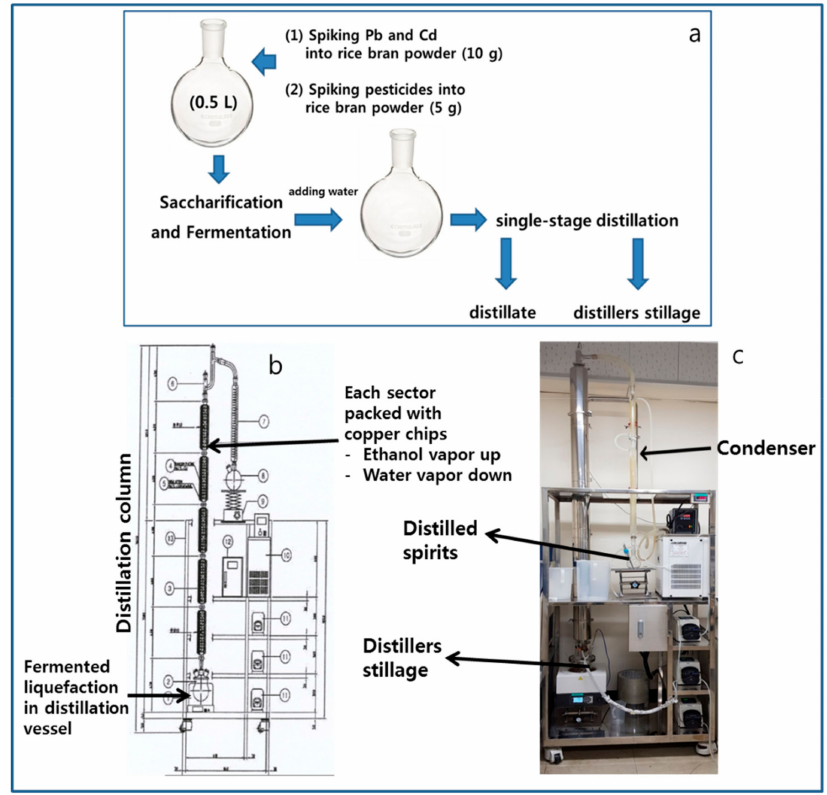
Figure 1. ( a ) Experimental scheme for single-stage distillation; ( b ) illustration of the pilot-plant scale distillation column; ( c ) photograph of the pilot-plant scale distillation column. Table 1. Content (ppm), distillate migration rate (%, DMR), and distillers’ stillage residual rate (%, DSRR) of the contaminated lead (Pb) and cadmium (Cd) from the single-stage distillation experiment. Pb Cd Limit of detection (LOD)